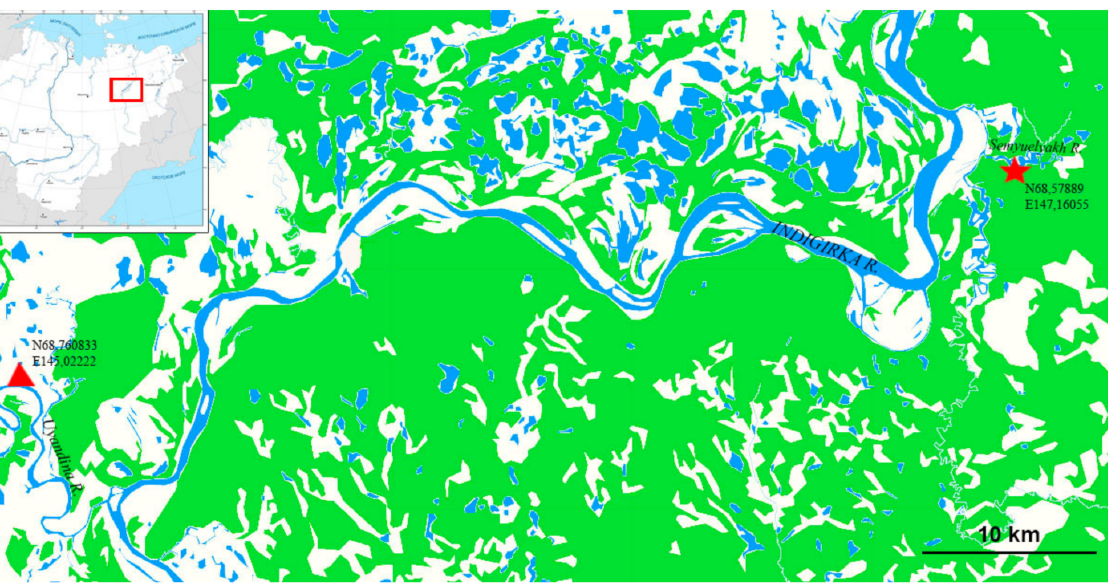
Figure 1. The locations of the cave lion cubs finds: on the Uyandina River (indicated by a red triangle) and on the Semyuelyakh River (indicated by a red